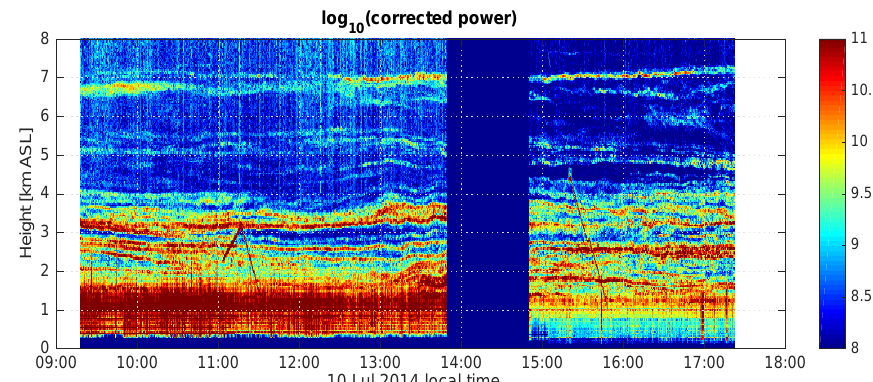
Figure 3. SOUSY daytime calibrated range-corrected received power for 10 July 2014 shows distinct turbulent layers from 500m up to 7km. The dropout of data between 14:00 and 15:00 was due to upgrades in the radar system that allowed for discrimination of echo returns bellow 1km. DataHawk flights over the radar were easily detected as an increase of the radar returns between 11:05 and 11:30 and between 15:21 and 15:46.